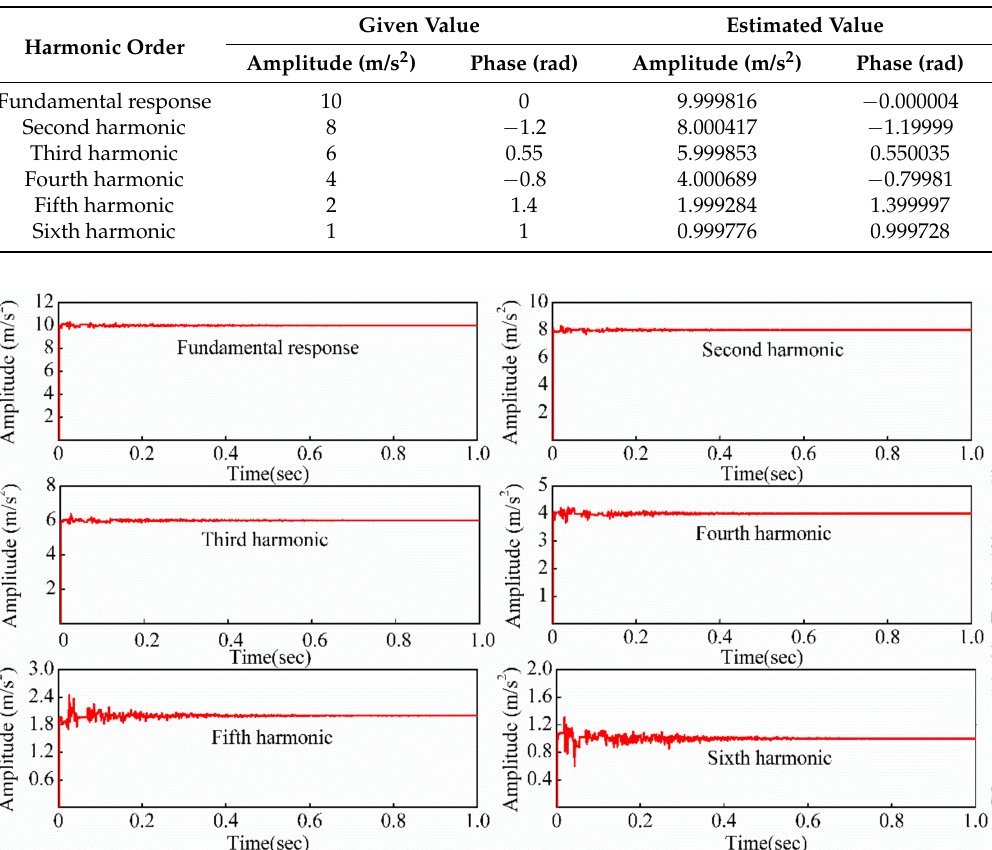
Table 2. The estimated value compared with given value.